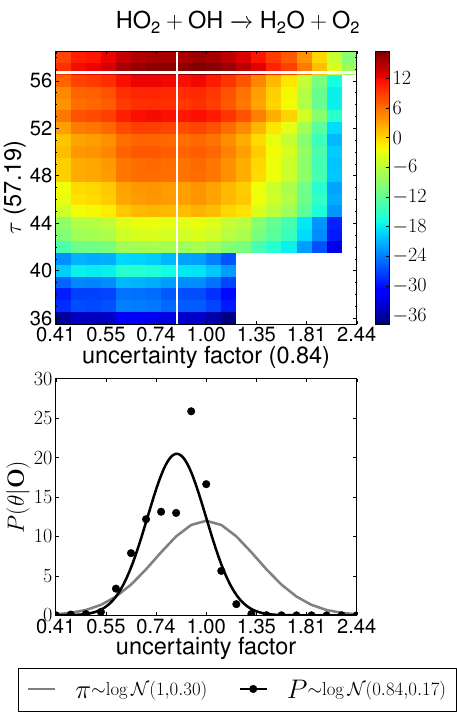
Fig. A7. Same as Fig. A1 for the HO 2 . +HO . → H 2 O+O 2 reaction.